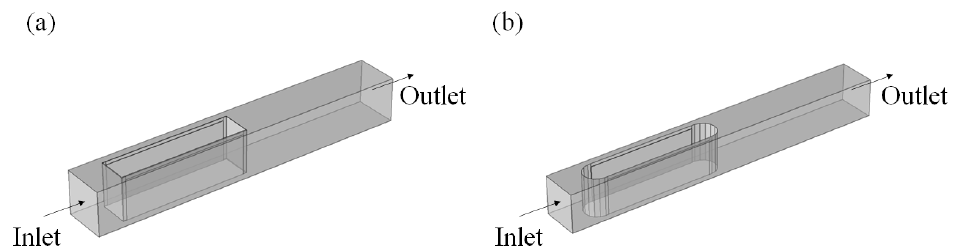
Figure 2. Geometry of the implemented numerical model with ( a ) rectangular profiles and ( b ) semi- hexadecagonal profiles in the